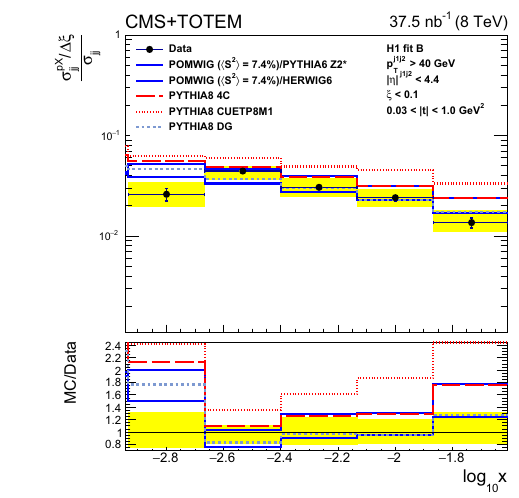
Fig. 5 Ratio per unit of ξ of the single-diffractive and inclusive dijet cross sections in the region given by ξ < 0 . 1 and 0 . 03 < | t | < 1GeV 2 , compared to the predictions from the different models for the ratio between the single-diffractive and nondiffractive cross sections. The pomwig prediction is shown with no correction for the rapidity gap sur- vival probability ( (cid:6) S 2 (cid:7) = 1) (left) and with a correction of (cid:6) S 2 (cid:7) = 7 . 4% (right).Theverticalbarsindicatethestatisticaluncertaintiesandtheyel-